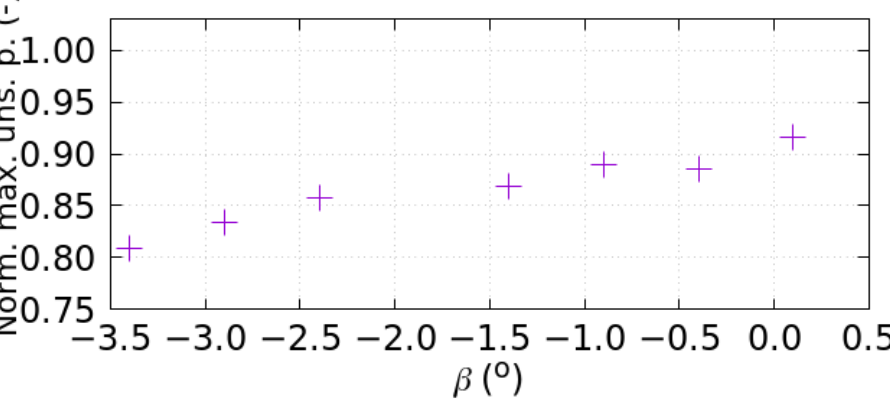
Figure 17. Comparing effect of varying β on maximum Fourier-decomposed unsteady pressure amplitudes.